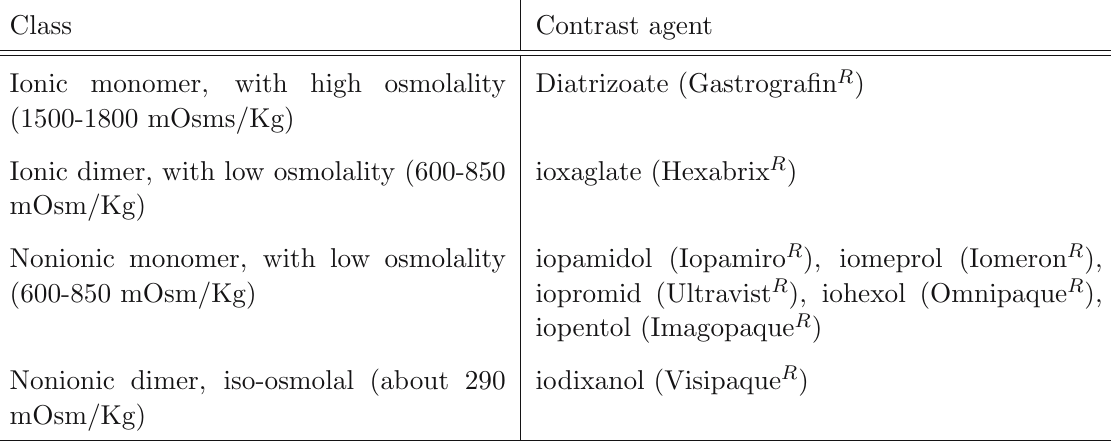
Table 4 The main iodinated radiocontrast agents.